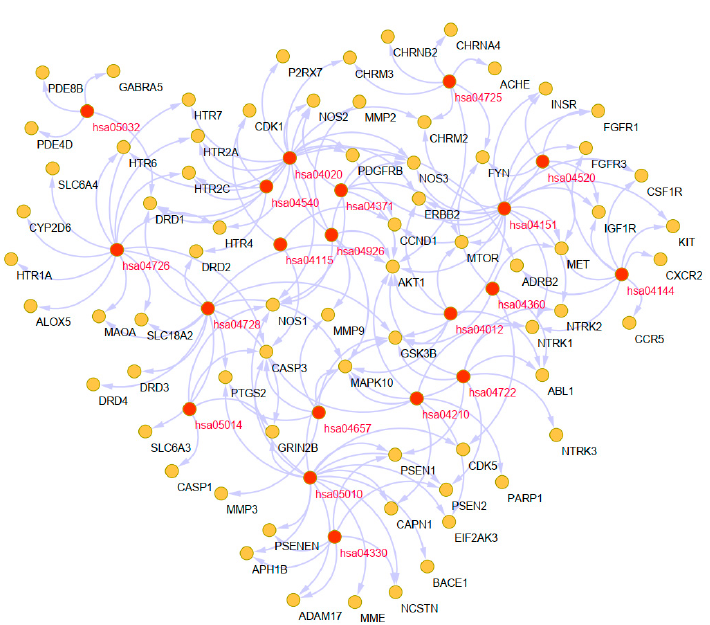
Figure 7. Target-enriched KEGG pathway network for UR alkaloids against AD. Red nodes represent enriched KEGG pathways, and brown nodes represent target proteins.